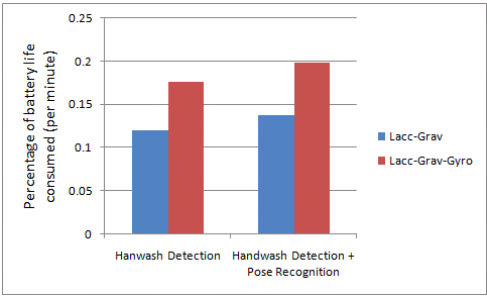
Figure 12: Average battery life consumption by the runtime clas- sification